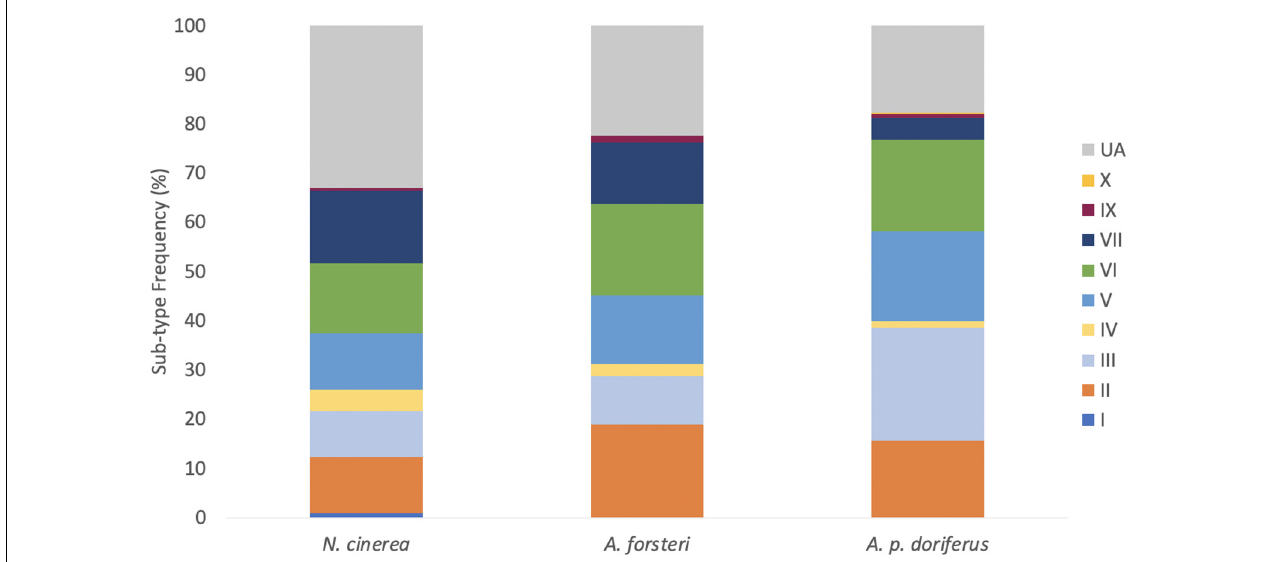
FIGURE 4 | Combined distribution of E. coli B2 sub-types for each species across breeding seasons sampled (2016–2019). Samples that could not be assigned to a sub-type were considered “unassigned” (UA). All nine sub-groups were identified in at least one of the three species.